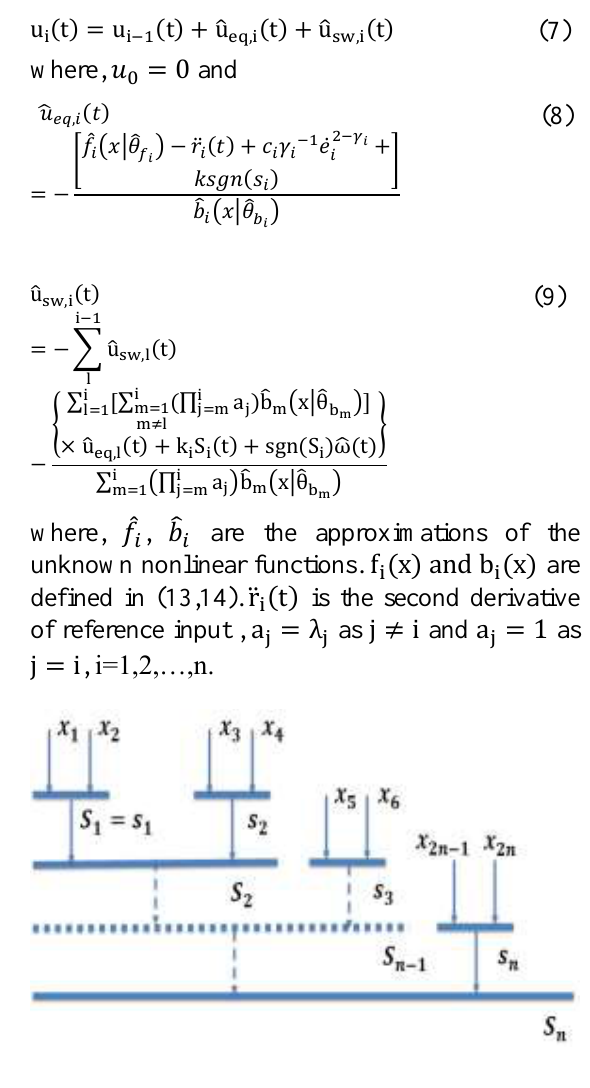
Figure 2. The hierarchical TSM layers